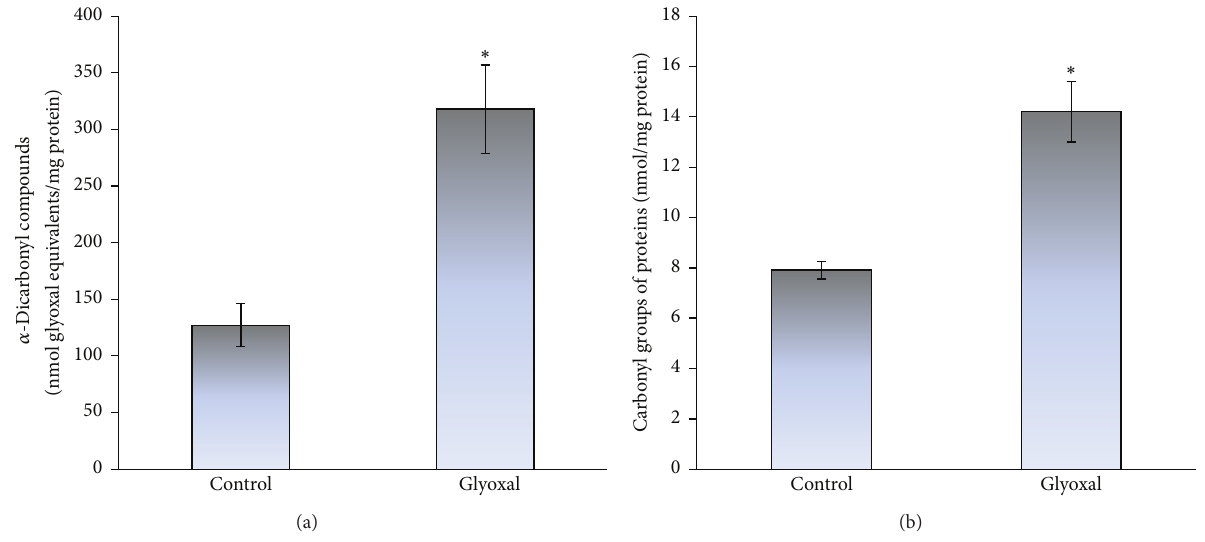
Figure 4: Effect of glyoxal on the level of carbonyl stress markers: 𝛼 -dicarbonyl compounds (a) and protein carbonyls (b), in S. cerevisiae YPH250. Results are shown as the mean ± SEM ( 𝑛 = 3 – 7 ). ∗ Significantly different from respective values for control cells (without glyoxal) with 𝑃 < 0.05